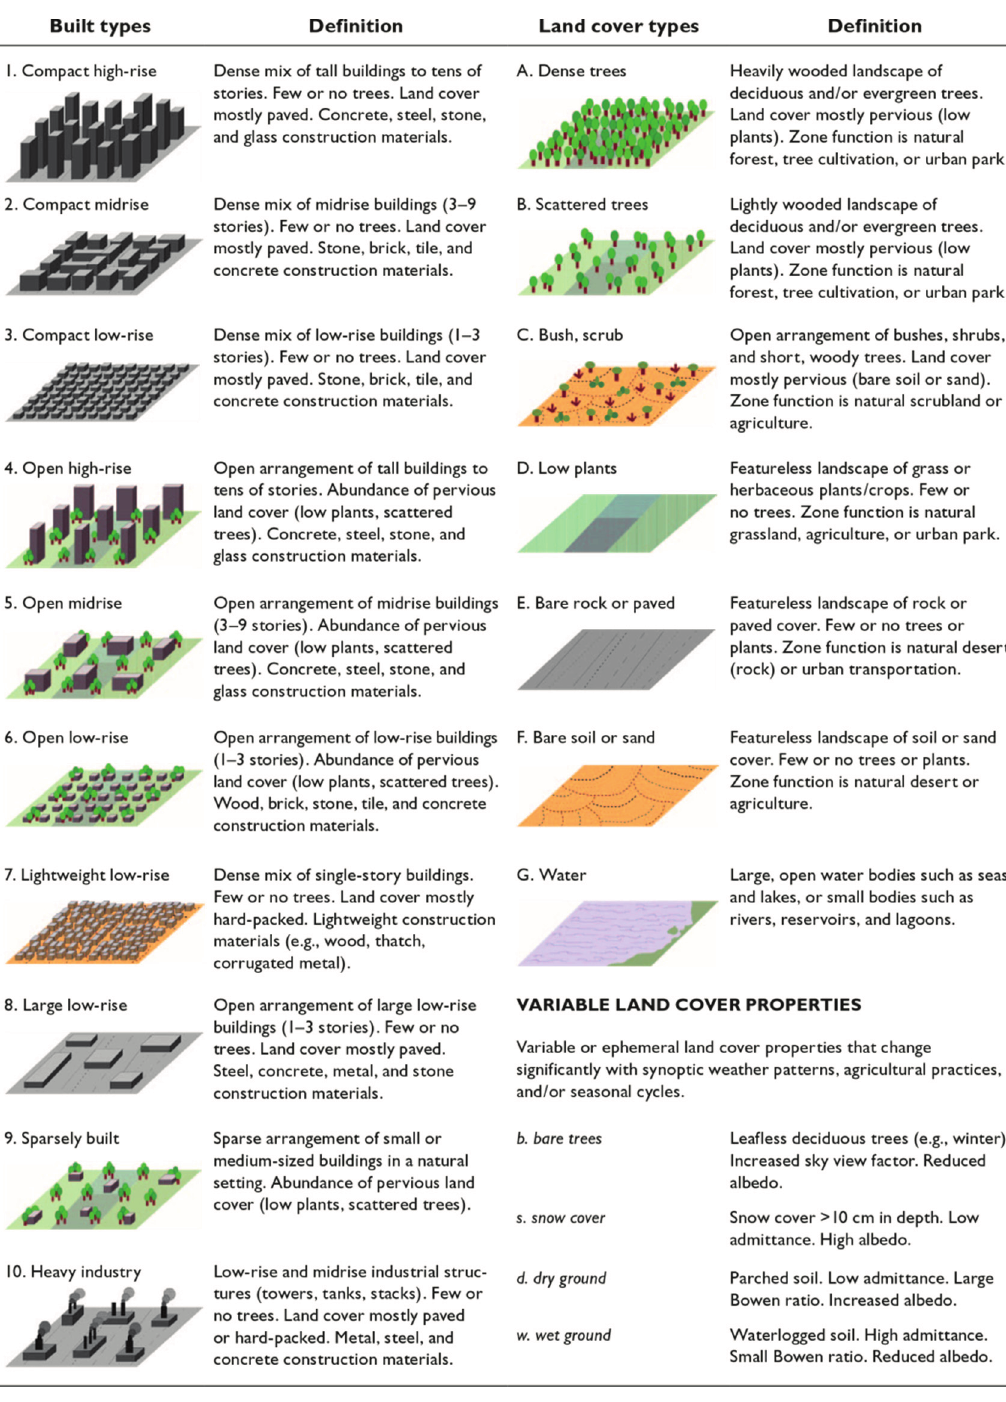
Figure 1. Local climate zone scheme